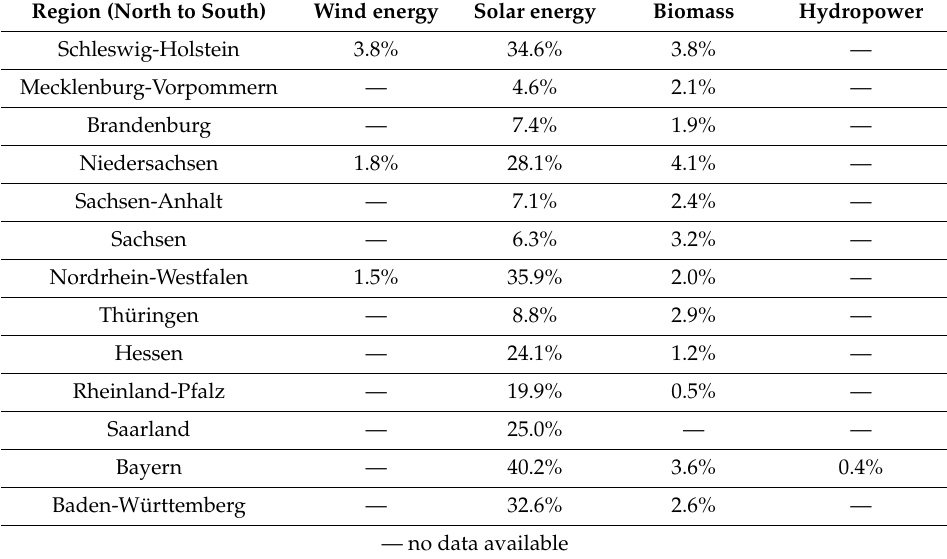
Table 1. Share of renewable energy generated by farmers in the respective federal state (region). Region (North to South) Wind energy Solar energy Biomass